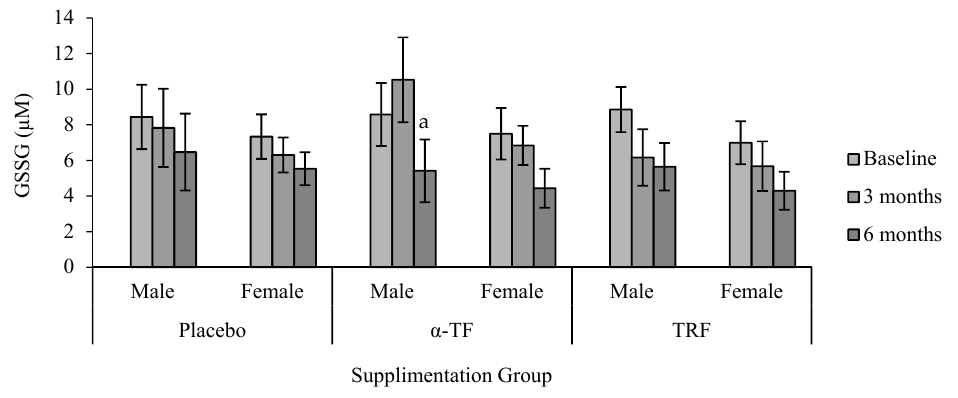
Figure 10. Effect of α -TF and TRF supplementation between males and females on GSSG concentration for 6 months. a = significantly different compared to 3-month α -TF (male), p < 0.05.